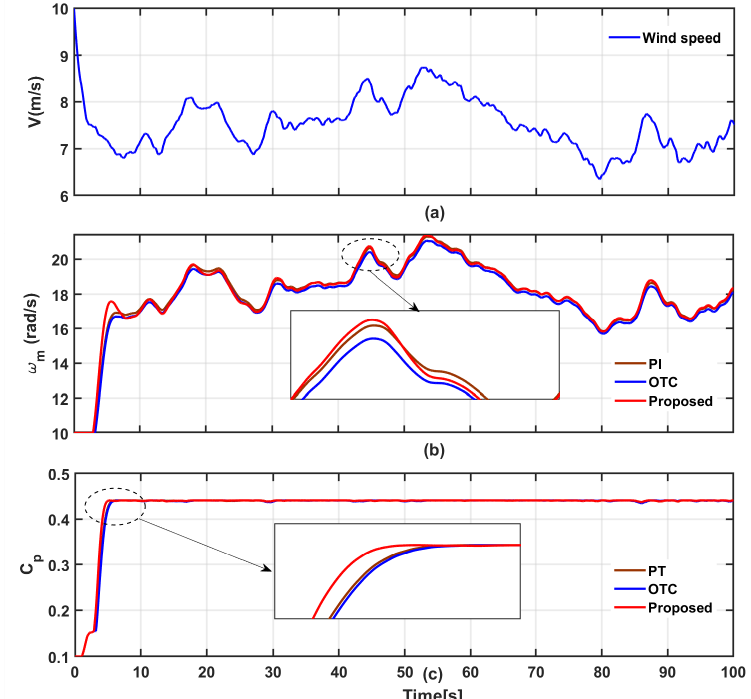
Figure 9. Simulation results for PMVG-based WECS under the case I with region II wind speed: